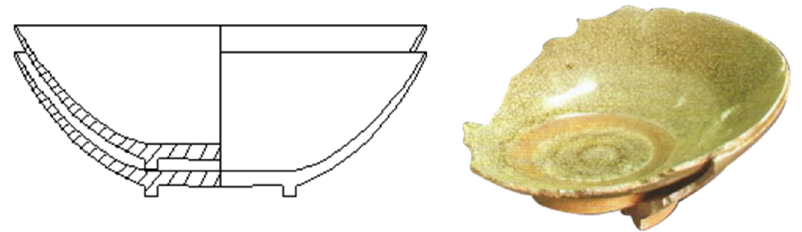
Figure 8. Potted and stacked firing samples unearthed from Xiaopi kiln ceramics and drawing.